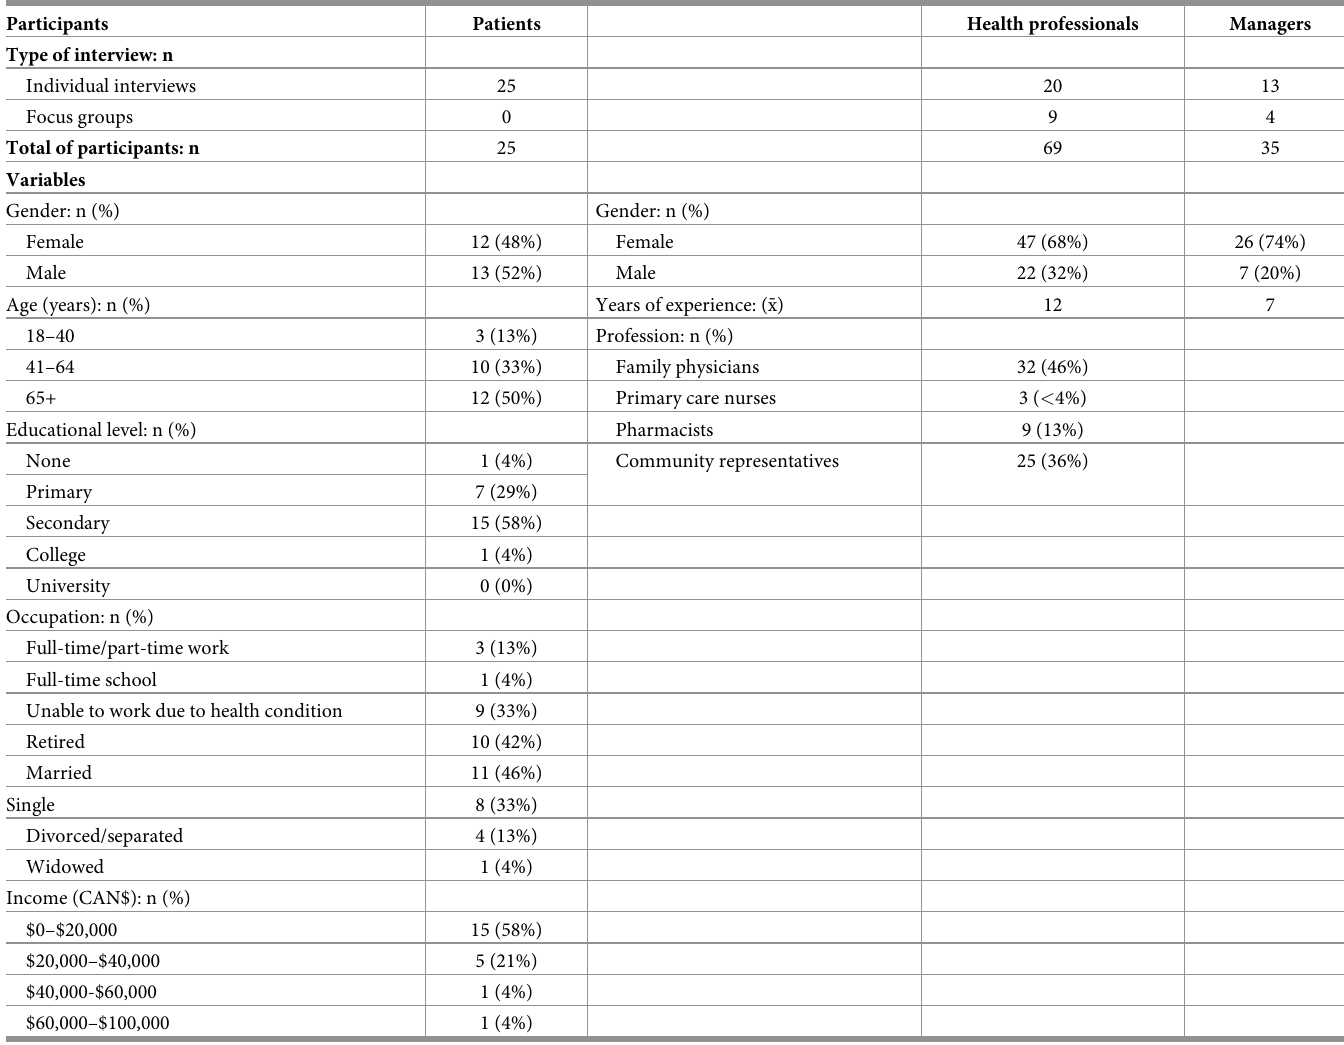
Table 1. Characteristics of the participants (n =